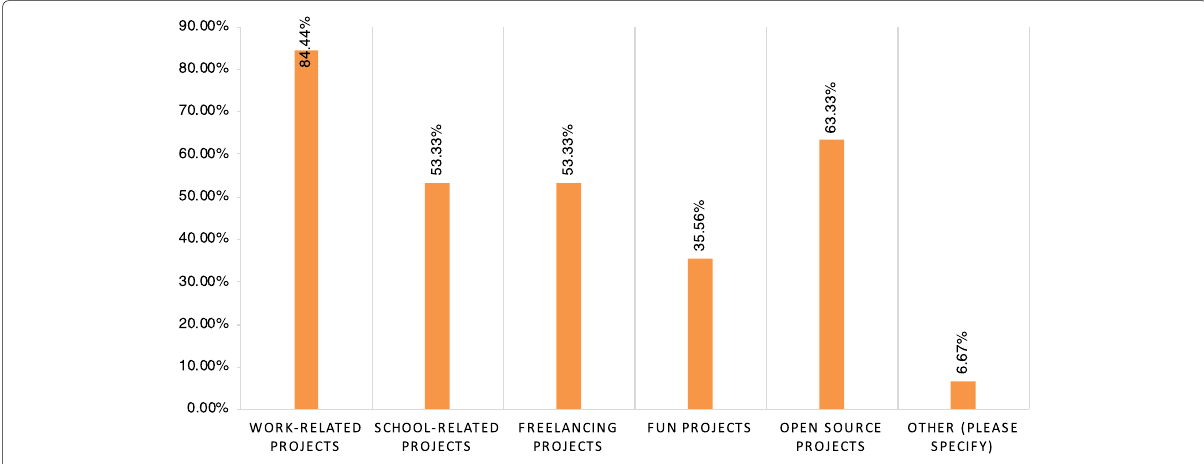
Fig. 7 Types of projects for which programmers would use the proposed